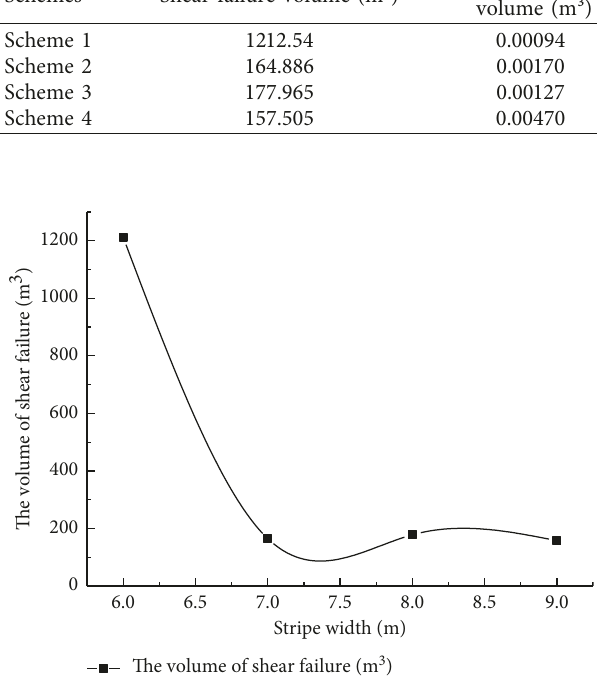
Figure 2: Volume of shear failure variation after the third